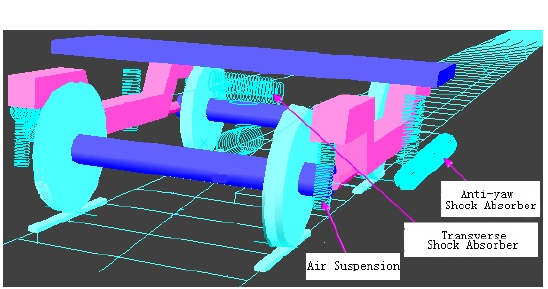
Fig. 1 Machinery model of bogie.